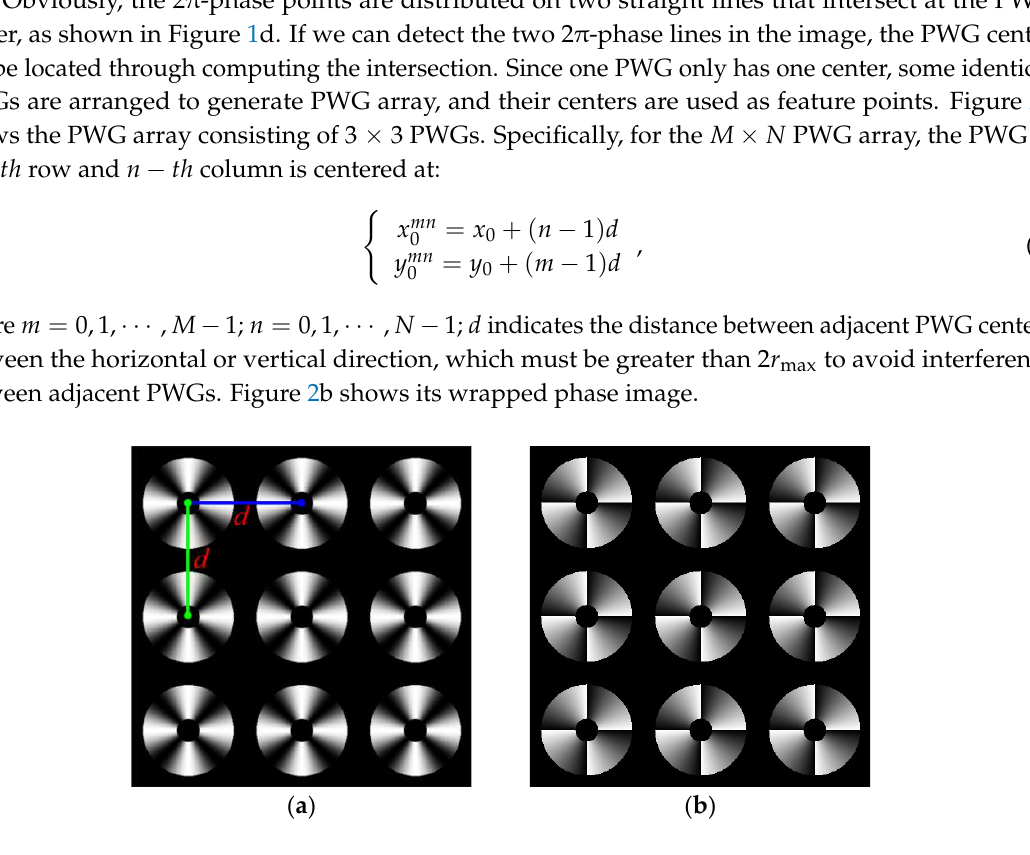
Figure 2. PWG array pattern. ( a ) a 3 × 3 PWG arrays image; and, ( b ) its wrapped phase.